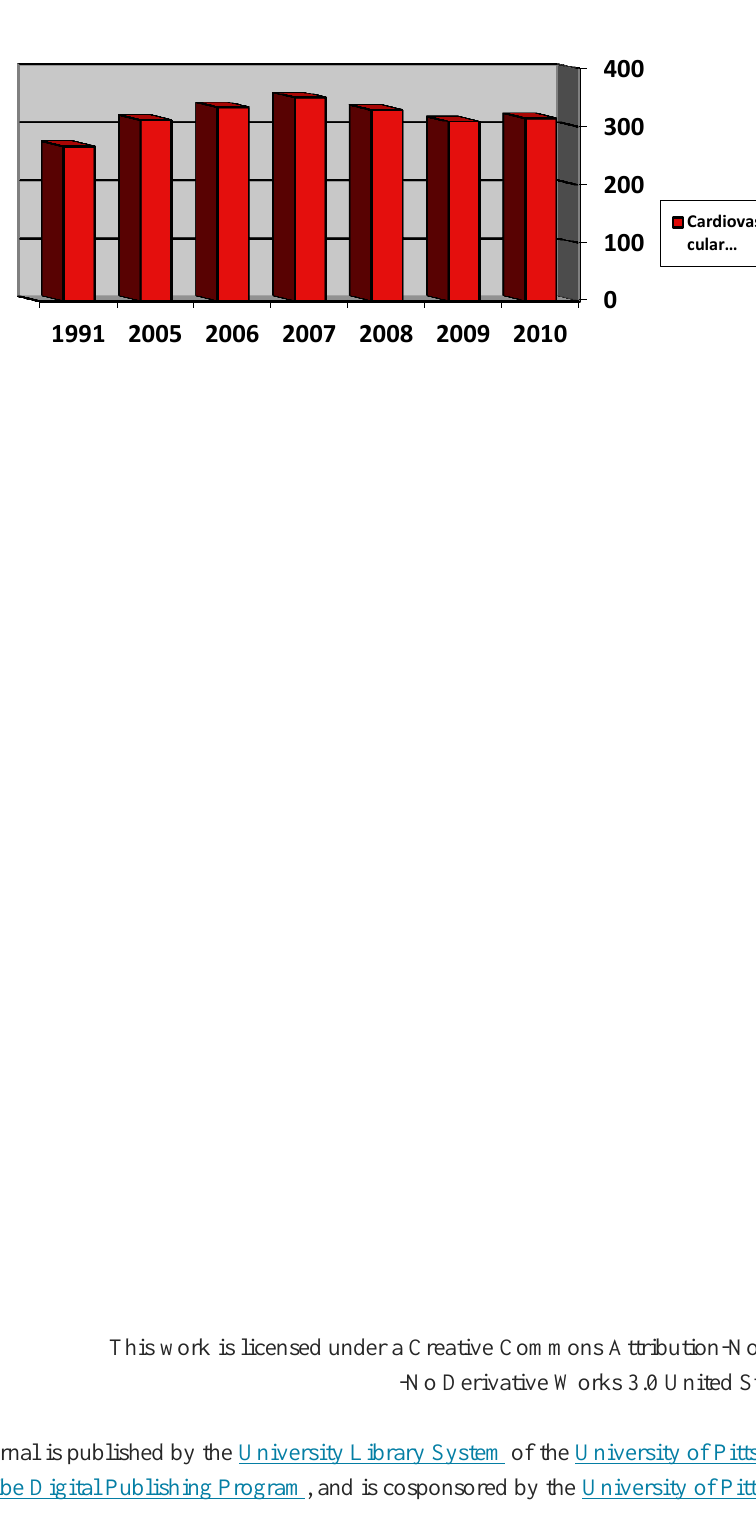
Figure 6: The death rate from cardiovascular diseases in Kyrgyzstan, ages